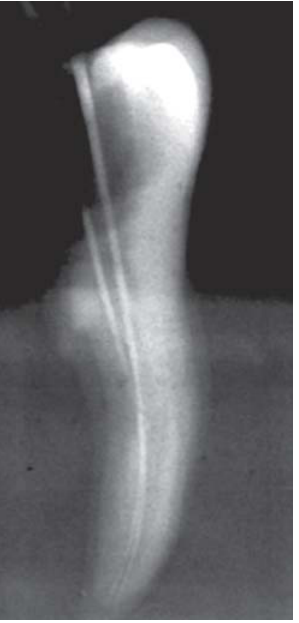
FIGURE 3- Computerized tomographic image before and after